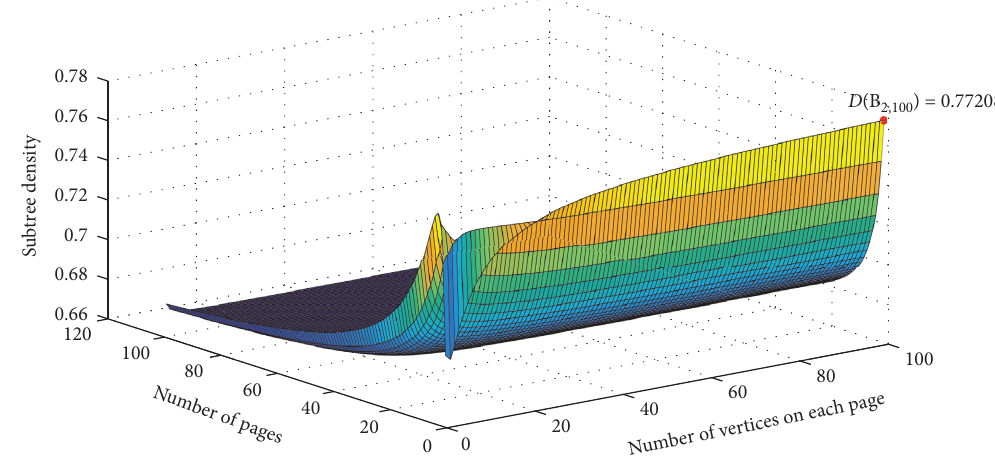
( n � 2 , 3 , ... , 101 ; k � 1 , 2 , ... , 100 ) . n,k